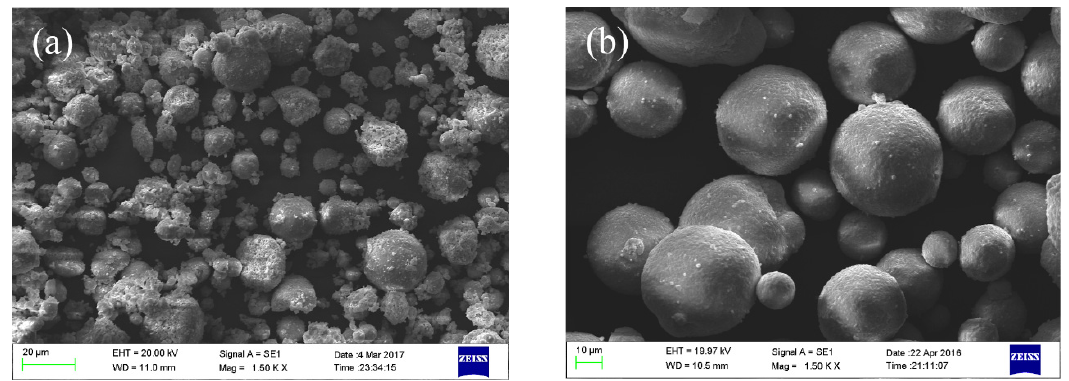
Figure 1. Morphologies of the 8YSZ powders. ( a ) Particle size ranging 15–25 μ m; ( b ) Particle size ranging 45–60 μ m.